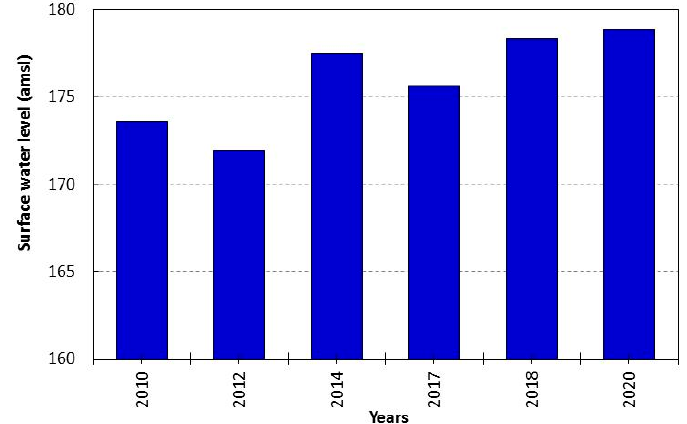
Figure 6. The relation between years and High dam lake water levels.